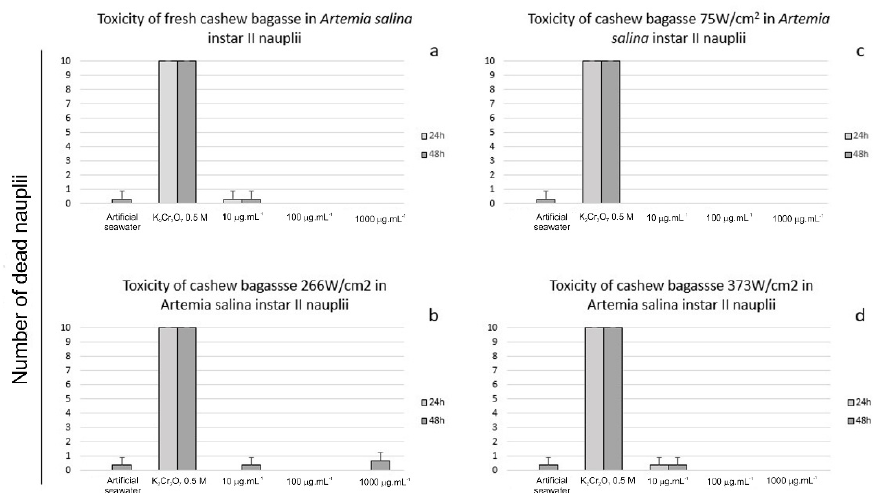
Figure 5. Acute toxicity of sonicated cashew apple bagasse (10, 100, and 1000 µ g/mL) in Artemia salina instar II nauplii at 24 and 48 h of exposure. No significant acute toxicity was noted in fresh ( a ), 75 W/cm 2 ( b ), 266 W/cm 2 ( c ), or 373 W/cm 2 ( d ), sonicated cashew apple bagasse at 24 or 48 h of exposure. In addition, negative control (artificial seawater) did not cause significant death of nauplii. Conversely, positive control (K 2 Cr 2 O 7 0.5 M) was lethal for 100% of individuals, including the 24 h of exposure. No significant protective effect was observed for unprocessed (Figure 6A), 75 W/cm 2 (Figure 6B), 226 W/cm 2 (Figure 6C), or 373 W/cm 2 (Figure 6D) sonicated cashew bagasse at 24 or 48 h of exposure. However, cashew bagasse processed at 75 W/cm 2 (1000 μ g/mL) prevented nauplii death after 24 h of exposure (Figure 6A). This data cannot assure the protective effect once the number of dead nauplii on 100 μ g/mL (Figure 6B) was similar. However, these data indicate a possible protective effect, especially in higher cashew ba- gasse concentrations. In general, the protective effect is dose-dependent, as Miguel et al. [21] described. Unlike C.A.B., other vegetable drinks such as blueberry juice [44] and fruit wines [45] also promoted a protective effect against oxidative stress. The number of dead nauplii was higher at 48 h at all treatments. According to Miguel et al. [21], 127.45 mM H 2 O 2 is the lethal concentration for a 24 h experiment. H 2 O 2 at LC 50 (127.45 mM) causes the death of nearly 50% of individuals at 24 h exposure. After 24 h of exposure to H 2 O 2 (127.45 mM) almost all nauplii were dead.